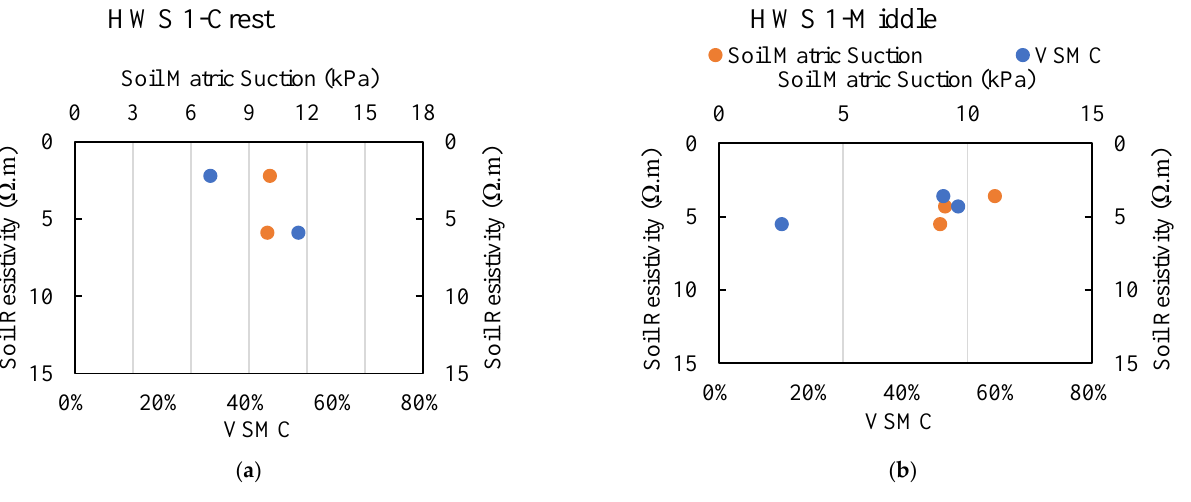
Figure 11. HWS 1 comparison of 2D ERI test profile with field instrumentation ( a ) At crest of the slope ( b ) At middle of the slope (1 m = 3.28 ft.; 1 mm = 0.039 in.; 1 kPa = 20.89 psf).